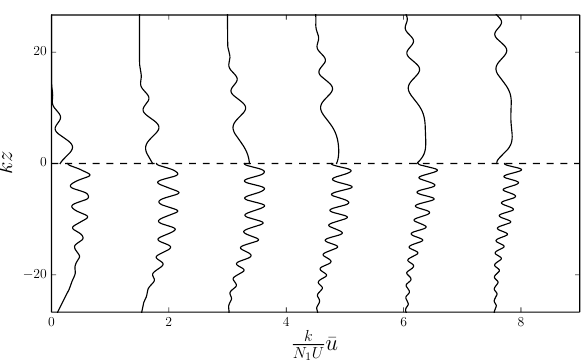
Figure 13. Vertical profiles of the mean flow in two layers for a se- quence of times. Each profile is shifted by a value of 1.5 for dis- play. The parameter values are n 1 /k = 1, N 2 /N 1 = 2, (cid:15) = 0.025, and α = 0.1. The line conventions are the same as Fig.